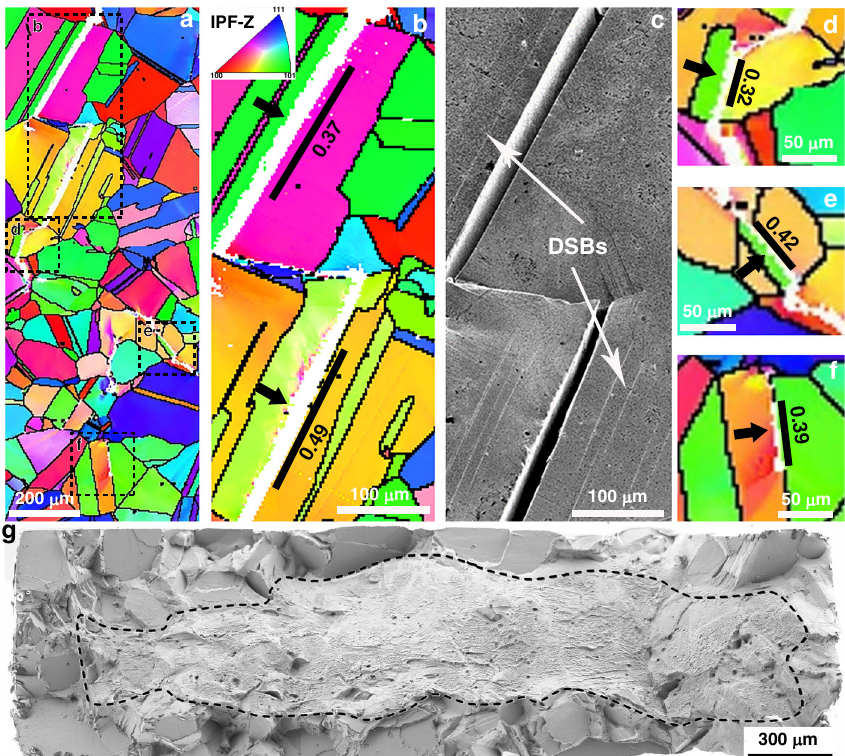
Fig. 5 H induced cracking and failure associated with TBs in H-charged sample. a Orientation map obtained by EBSD on the sample surface after SSRT to failure; b a magni fi ed image from ( a ) showing long cracks associated with TBs, which are indicated by black arrows, and Schmid factor of the TBs are noted; c the corresponding secondary electron image of ( b ) with dislocation slip bands (DSBs) indicated; d – f more magni fi ed images from the framed regions in ( a ) to show cracks along relatively short TBs and extended to the neighbouring grains; The inset in ( b ) is the colour legend of all orientation maps. g A SEM image of the fracture surface showing very fl at facets in the quasi-cleavage regions, where H was present during